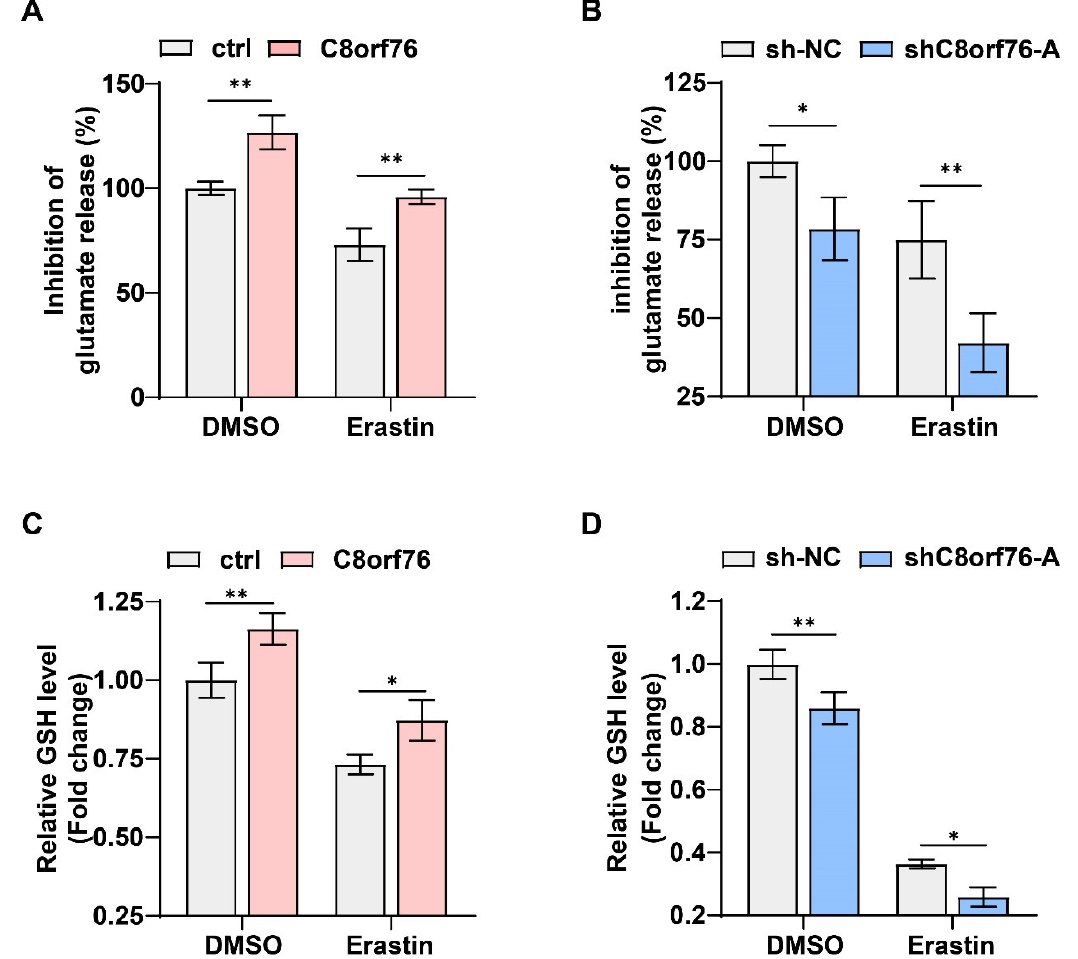
Figure 7. C8orf76 regulates xCT activity and glutamate secretion. ( A , B ) While modulating C8orf76 expression, the amount of glutamate released into culture medium was detected after treatment with or without erastin (5 μM) in HCC cells for 6 h. ( C , D ) Intracellular GSH levels were measured in HCC cells with C8orf76 alteration in the presence or absence of erastin (5 μM) for 12 h. Data was presented as mean +SD. * p < 0.05; ** p < 0.01; *** p < 0.001; ns, no significant.